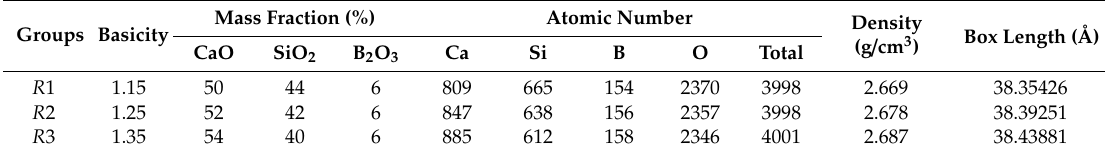
Table 2. Component content, atomic number, density, and box length of CaO-SiO 2 -B 2 O 3 system at 1600 ◦ C.